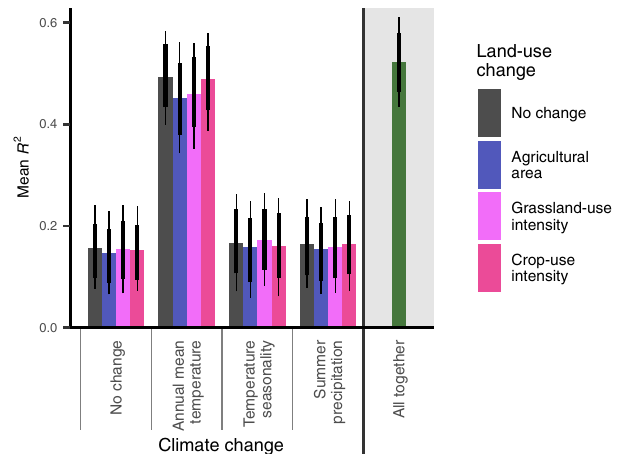
Fig.4|Explainedvarianceoflong-termspeciestrendsfordifferentclimateand land-use scenarios. Regression model results (Fig. 3) just re fl ect relationships of short-term trends to short-term changes, which can be of different relevance to explain long-term trends depending on the long-term change of drivers. Thus, basedontheresultsoftheregressionmodelonlyincludingspeciesofagriculturally in fl uenced habitats (Supplementary Table S3), 40-year trends in mean occupancy (acrossthewholeofSwitzerland)werepredictedforall276speciesforscenariosof no climate and land-use change (i.e., change assumed to be zero across all zones and time intervals) and for different combinations of single measured trajectories of climate and land-use variables. The R 2 values (squared Pearson correlations) indicatehowwellthepredictionsalignwiththeobservedlong-termspeciestrends. Thegreenbarontherightshowsthematchforthepredictionswithallclimateand land-use variables following theirmeasured trajectories(analogousto the R 2 of the modelpresentedinFig.3a).Barsshowmeansof theposteriordistribution;vertical lines show 80%- and 95% credible